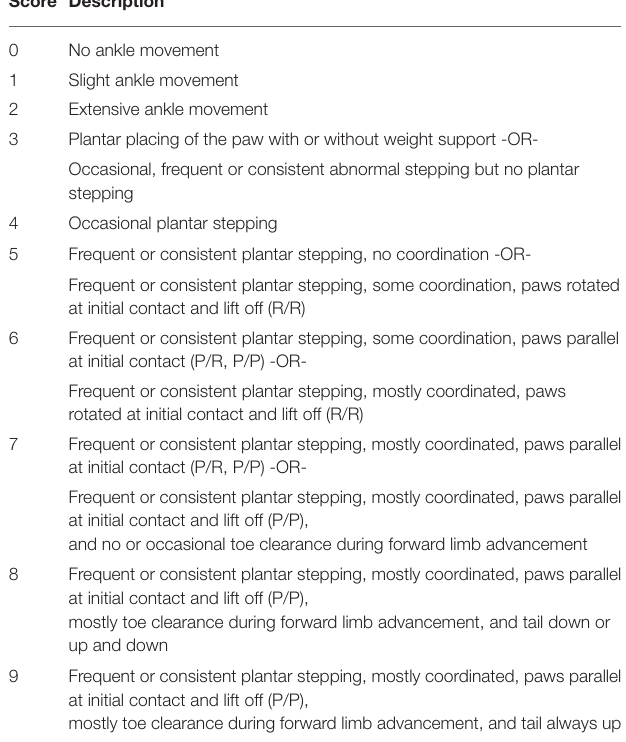
TABLE 3 | Marmoset Motor Scale for